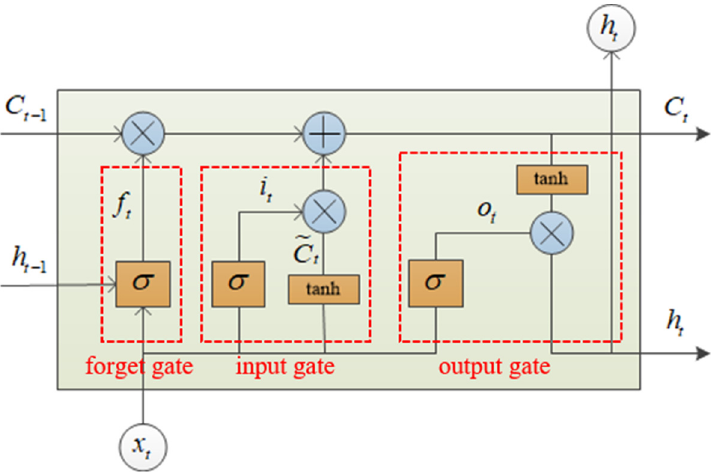
Figure 2. LSTM neural network structure diagram including forget gate, input gate, and output